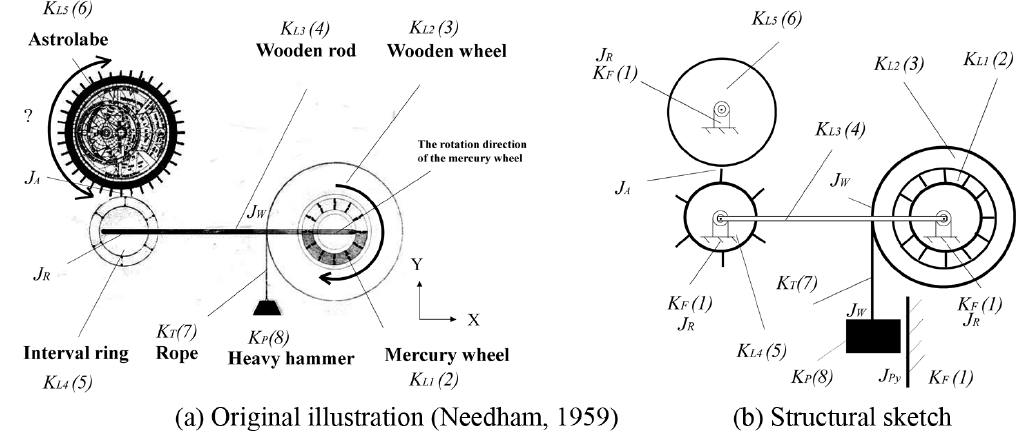
Figure 12. Alfonso X of Castile’s mercury clock.